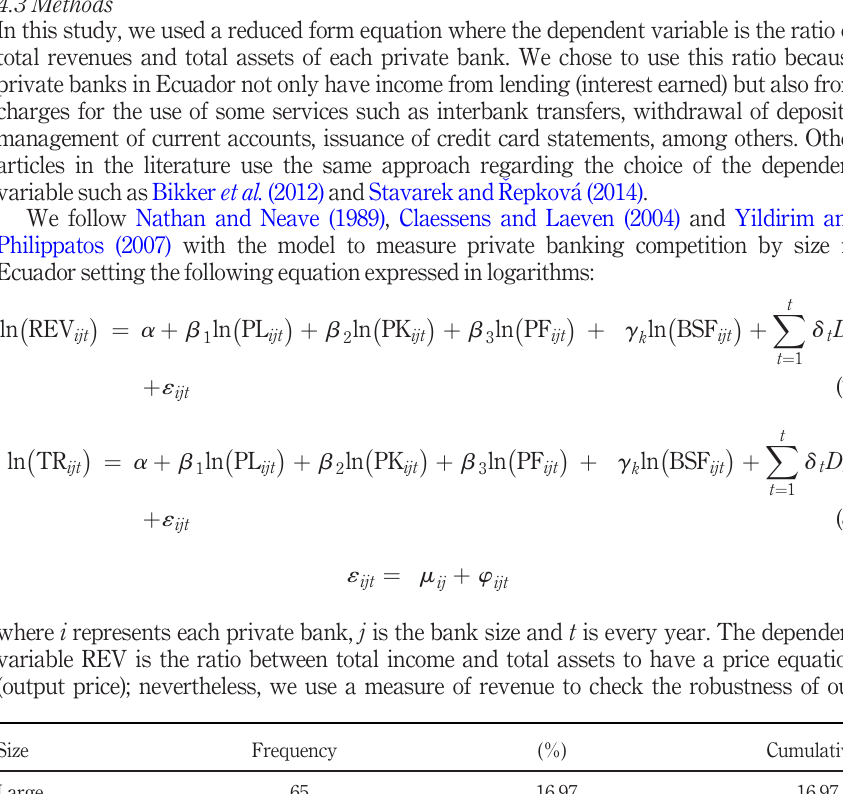
observations per bank size for the sample with